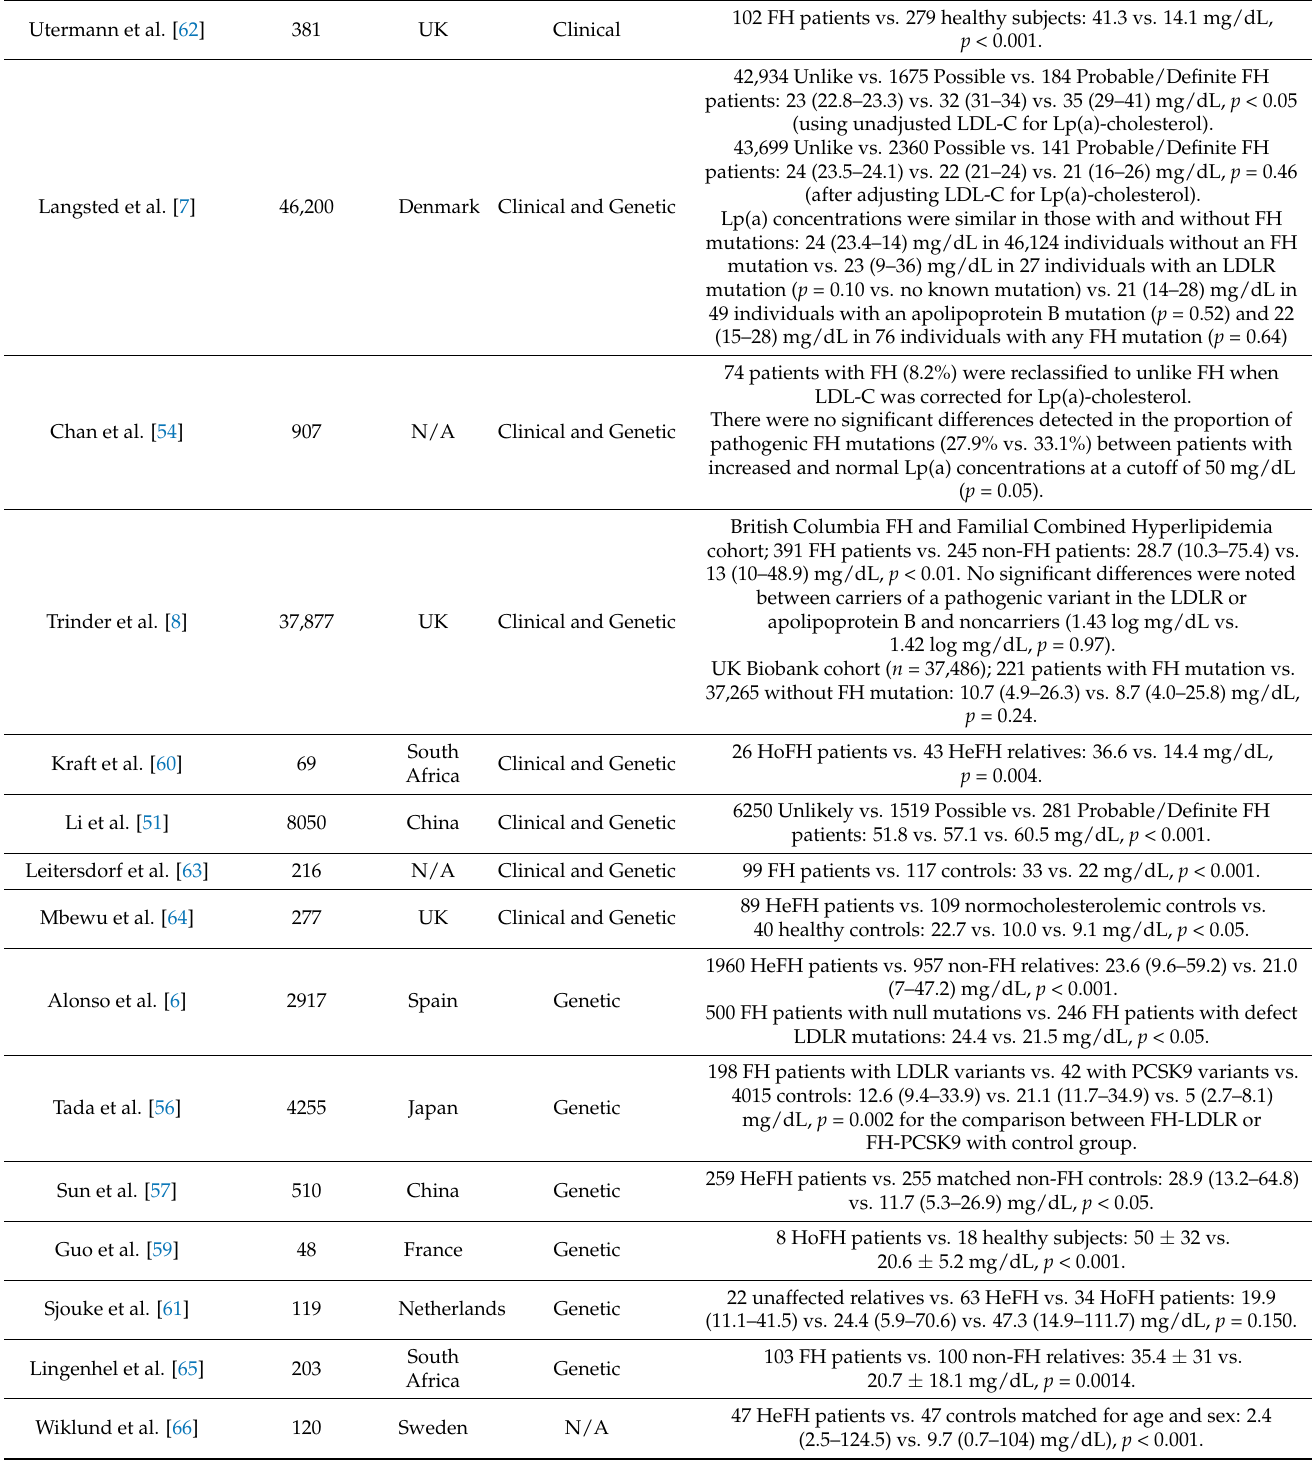
Abbreviations: FH: familial hypercholesterolemia; HeFH: heterozygous FH; HoFH: homozygous FH; LDL-C: low-density lipoprotein cholesterol; LDLR: low-density lipoprotein receptor; Lp(a): lipoprotein(a); N/A: not applicable; PCSK9: proprotein convertase subtilisin/kexin type